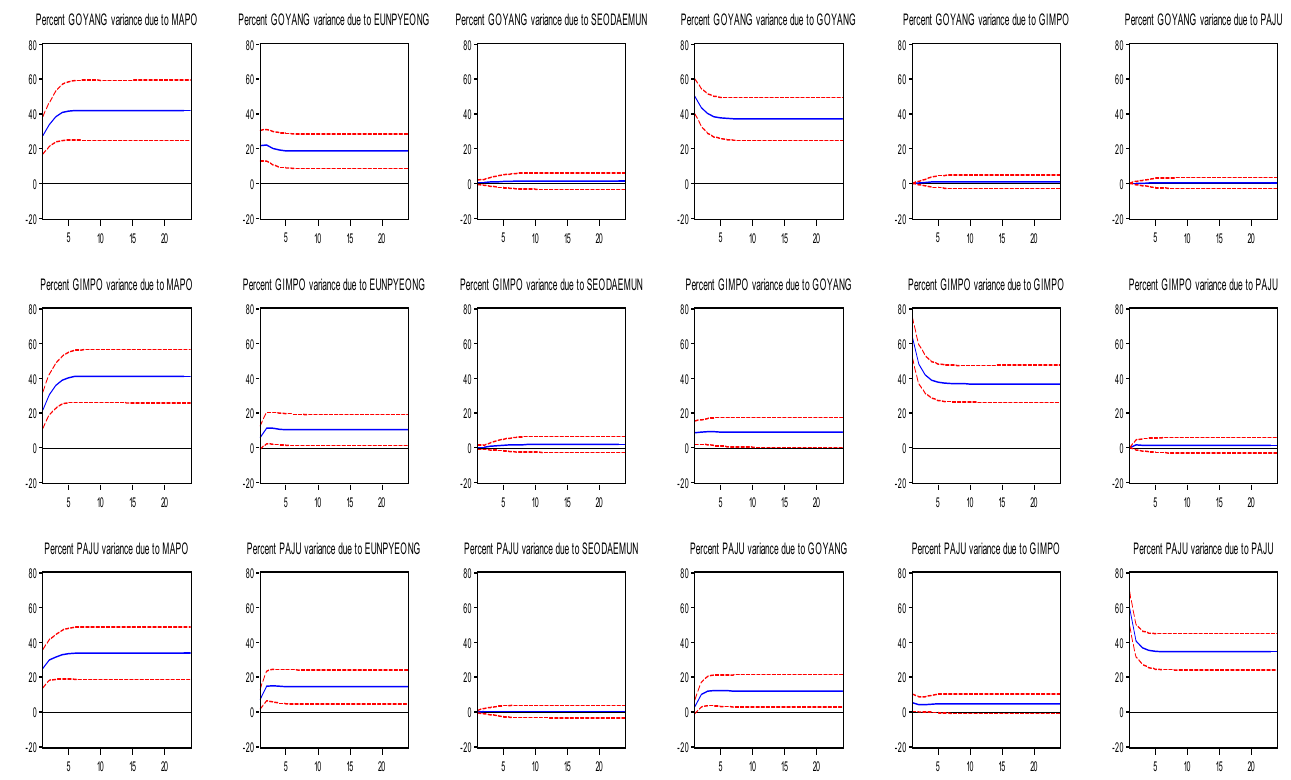
Figure 10. Variance decomposition analysis of the housing sales markets in the Gyeongeui region.